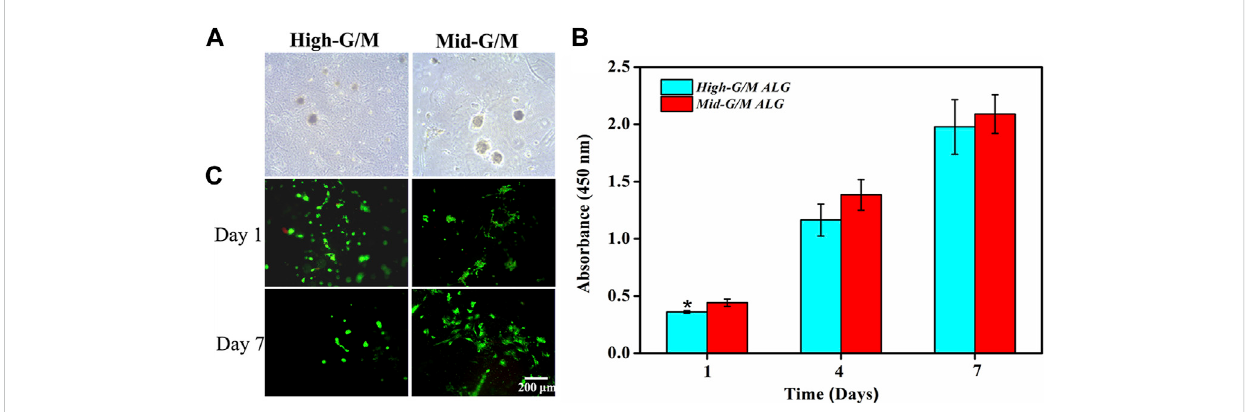
FIGURE 3 Proliferation and live/dead staining of chondrocytes on ALG/COL hybrid hydrogels. (A) Phase contrast images of chondrocytes cultured on hydrogels with different G/M ratios for 3 days. (B) Cell proliferation was determined by CCK-8 assay for 1, 4, and 7 days. (C) Images of live and dead chondrocytes cultured on ALG/COL hydrogels withdifferentG/M ratios. Datesare representedas themean± SD(n=3).(* p < 0.05indicates asigni fi cant difference between the